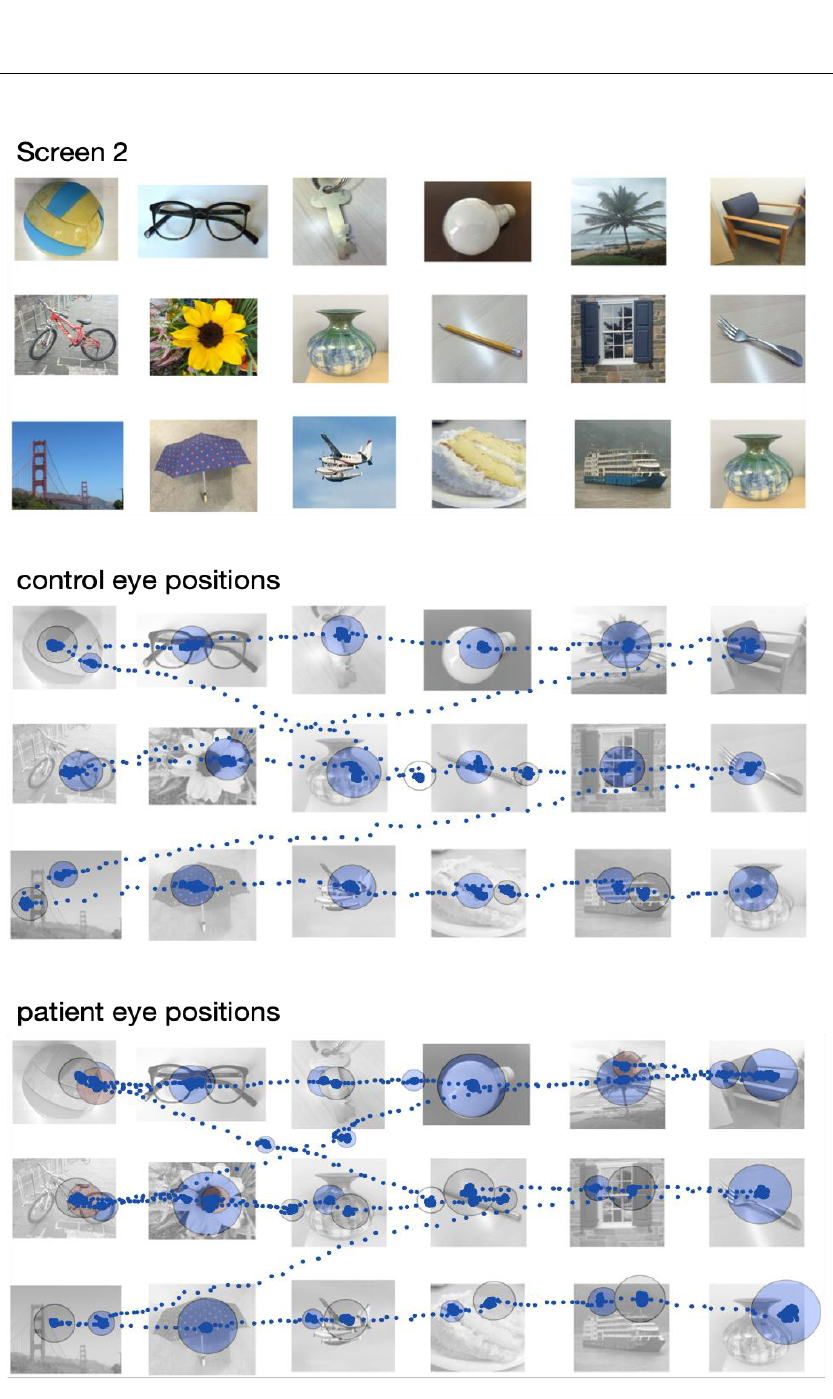
Figure 2. The digitized Mobile Universal Lexicon Evaluation System (MULES). Screen 2 of the digitized MULES ( top ). An example of eye position traces superimposed on MULES images in a single control participant ( middle ). An example of eye position traces superimposed on MULES images in a single participant with a history of concussion ( bottom ). In the lower two panels, saccades are shown as small blue dots, whereas fixation duration (also termed inter-saccadic intervals, ISI) is indicated by the size of larger circles. Circles are colored blue for the first fixation of a picture, grey for subsequent fixations, and red when fixating on a previously viewed picture.